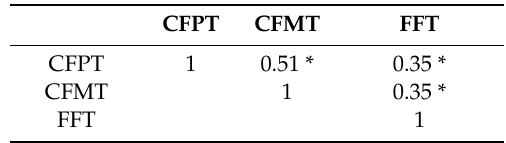
Table 5. Pearson’s correlations for the entire self-referred DP group’s ( N = 165) performance on the CFPT, CFMT and famous face test